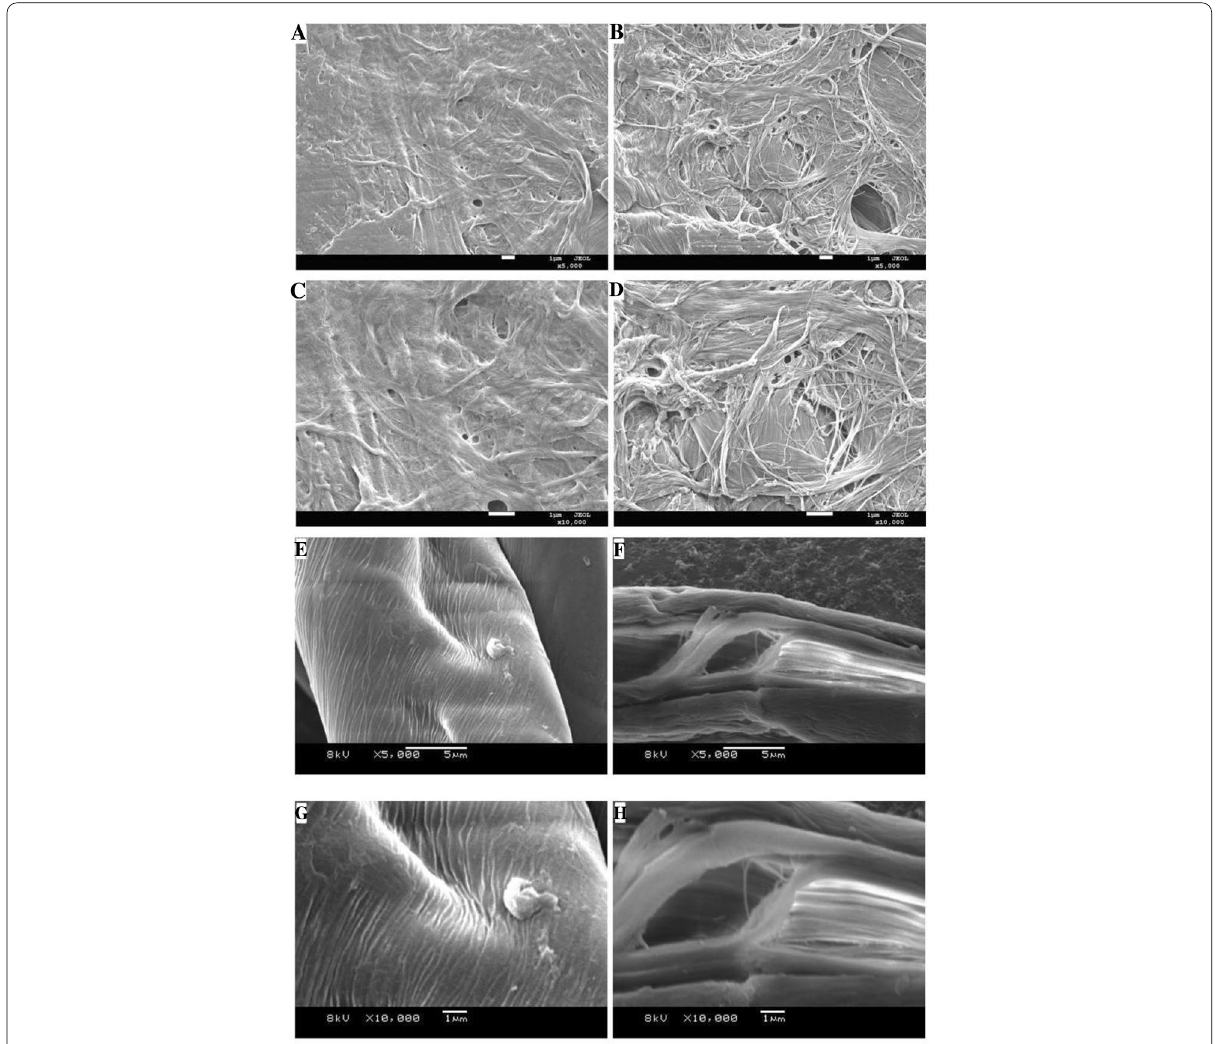
Fig. 6 Scanning electron microscopy observation of different cellulose substrates: A , C ddH 2 O-treated filter paper at A 5000 CxEXL22-treated filter paper at B 5000 at F 5000 and H 10,000 ×